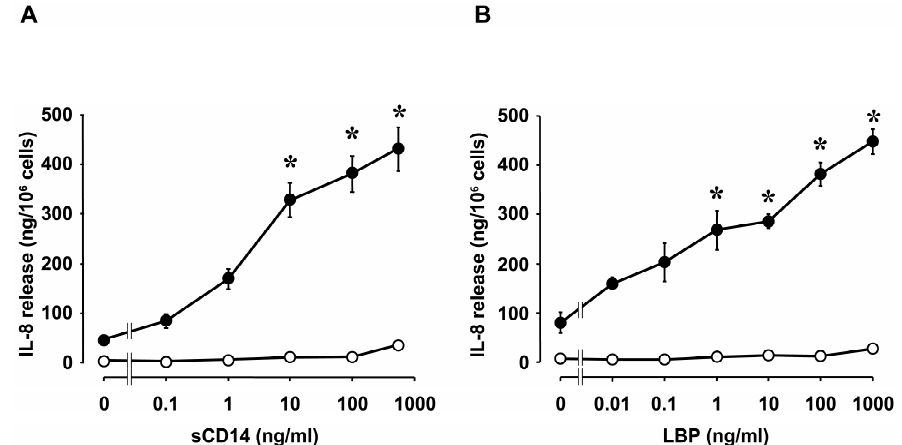
Figure 2. Concentration-dependent effects of soluble cluster of differentiation 14 (sCD14) and LPS binding protein (LBP) on IL-8 release by human corneal fibroblasts. Cells deprived of serum for 24 h were incubated for 24 h in the absence (open circles) or presence (closed circles) of LPS (10 ng/mL) and with the indicated concentrations of sCD14 ( A ) or LBP ( B ), after which the amount of IL-8 released into the culture medium was determined. Data are means ± SEM of triplicates from representative experiments. * p < 0.01 versus the corresponding value for cells incubated with LPS in the absence of sCD14 or LBP. Reprinted with permission from [24].